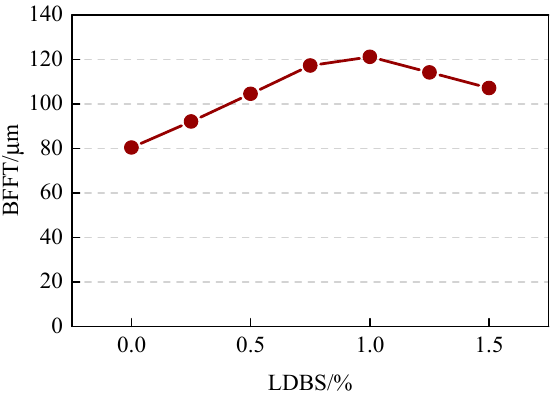
Figure 2. Relationship between the amount of LDBS added and the BFFT.